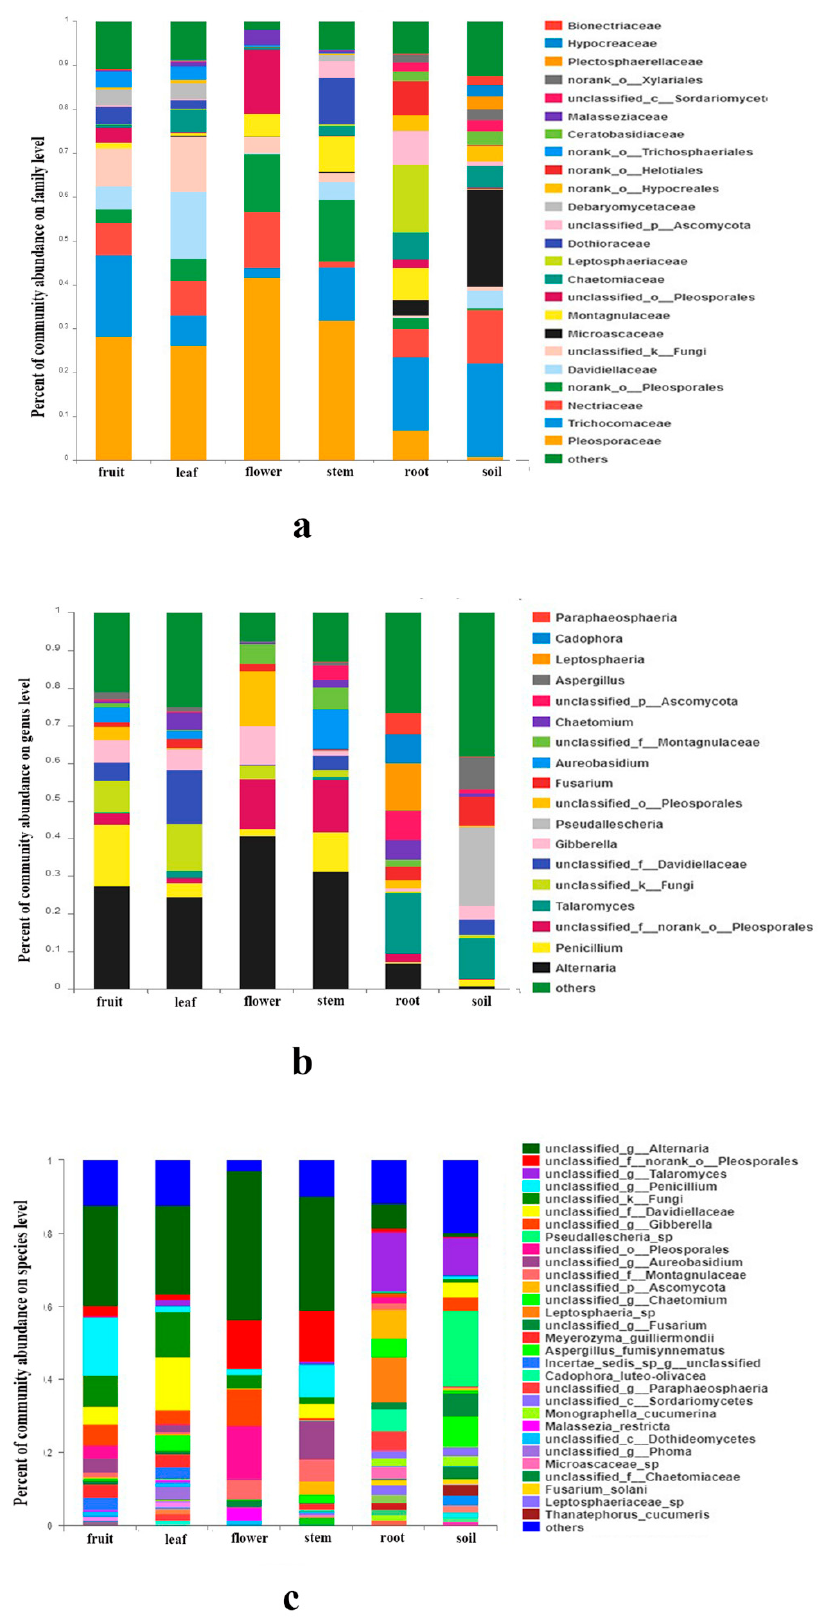
Figure 2. Fungal abundance in different organs and soil: ( a ) at family level; ( b ) at genus level; ( c ) at species